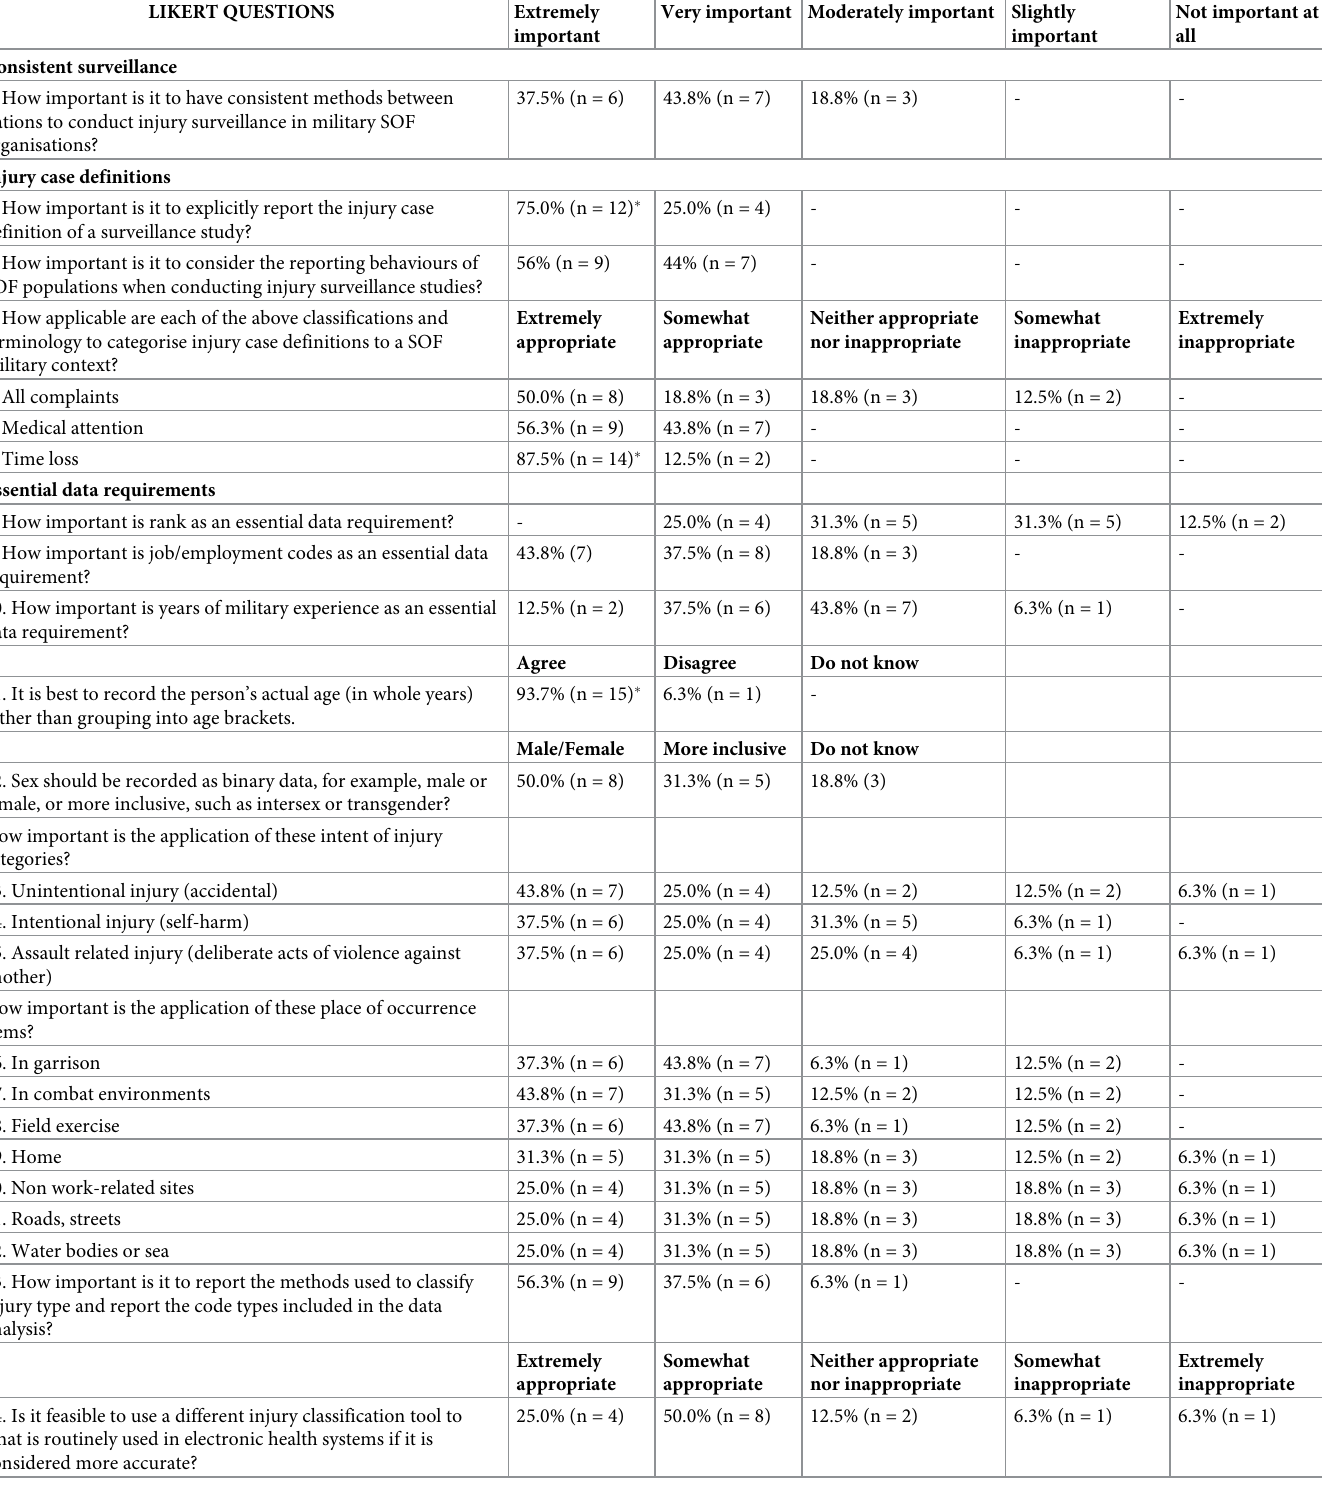
Table 2. Experts’ responses for in the first-round Delphi questionnaire for SOF injury surveillance data